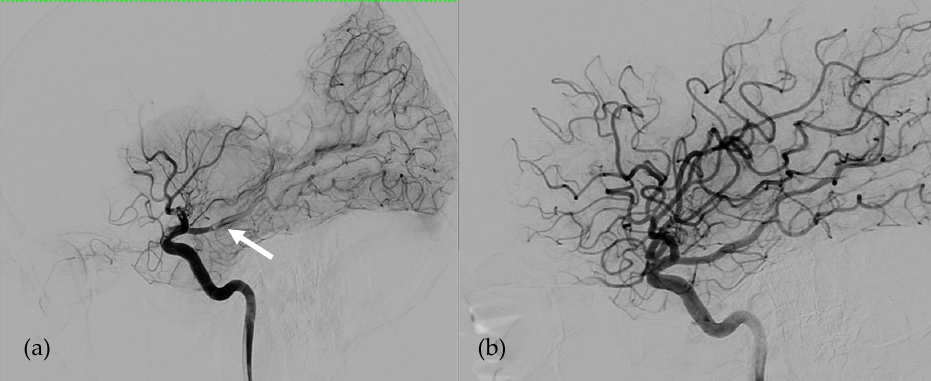
Figure 2. Angiographies of Right Internal Carotid Artery in patient 2. ( a ) Right Middle Cerebral Artery occlusion responsible for left hemiplegia just before revascularization (the white arrow shows the thrombus). ( b ) Early after endovascular revascularization by mechanical thrombectomy 70 min after the onset of the symptoms.